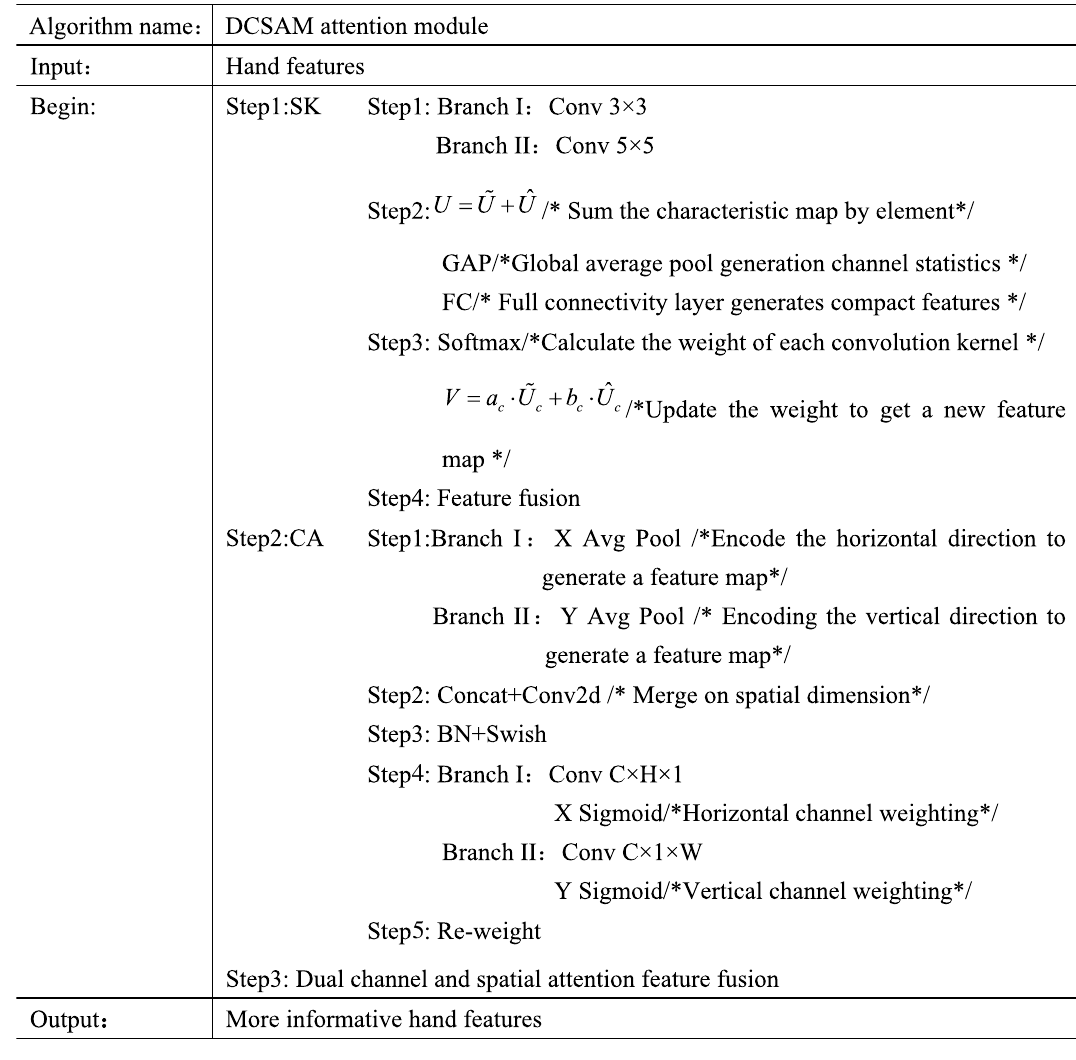
Figure 8. DCSAM attention module pseudocode.